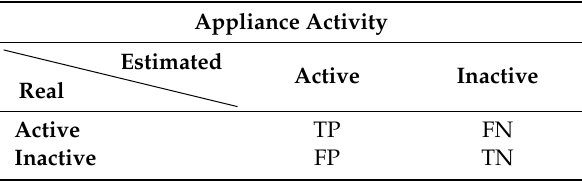
Table 3. Designations of the numbers of correct and incorrect estimations.